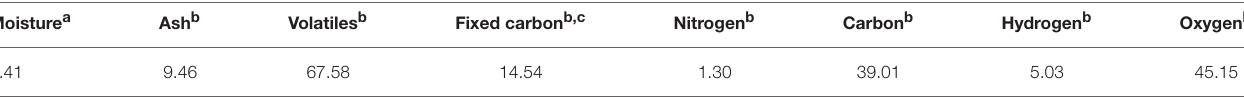
TABLE 1 | Proximate and ultimate analysis results of corn stalk (wt. %). Moisture